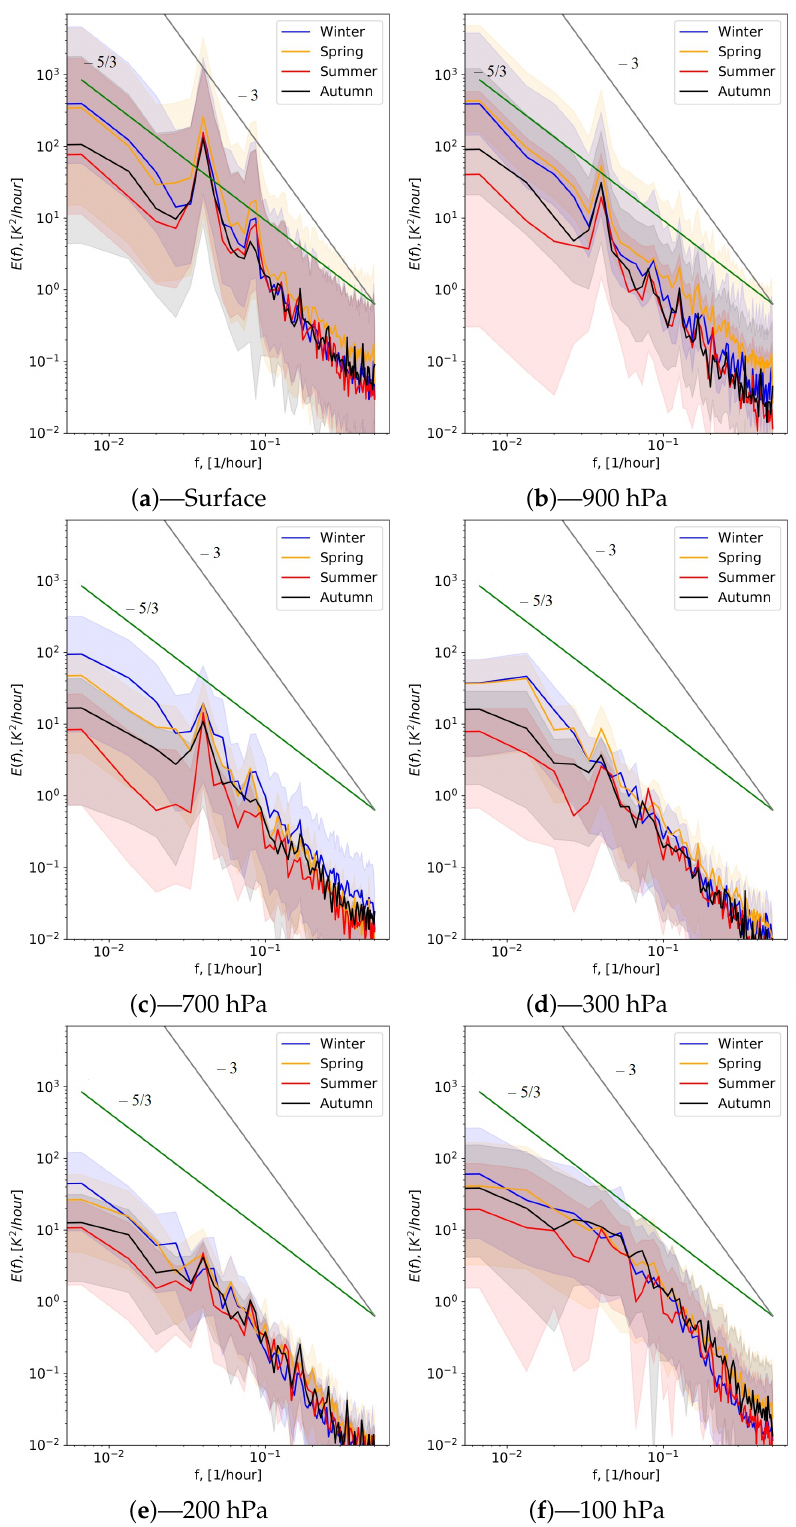
Figure 6. Frequency dependencies of power spectral density of air temperature fluctuations at the Hoa Lac observatory